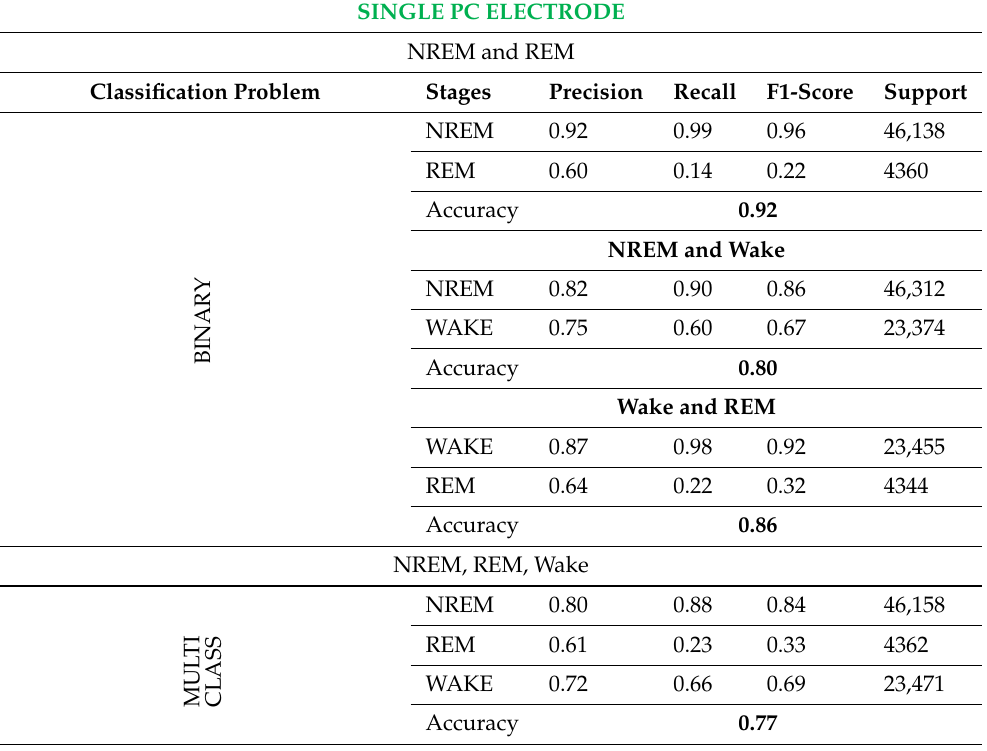
Table 3. Performance measures for binary and multiclass classifications.